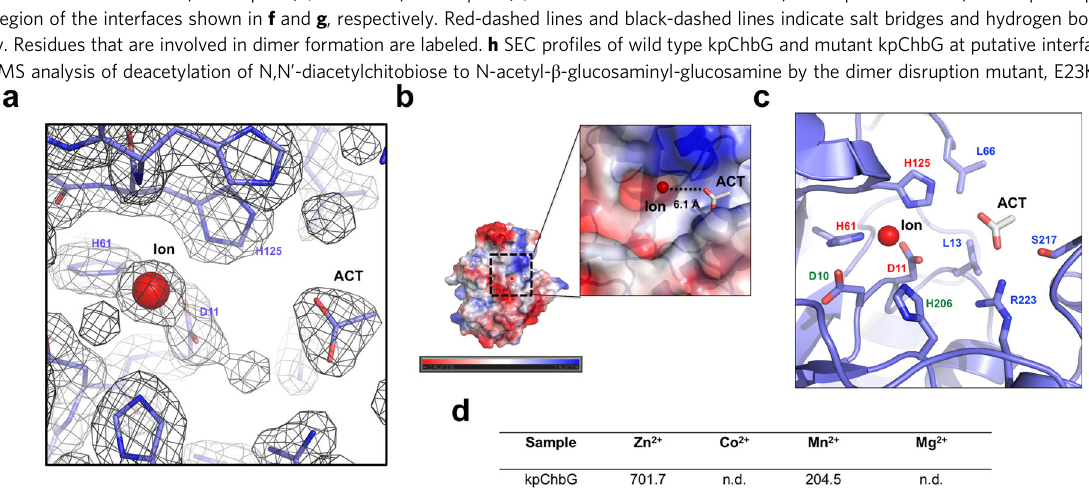
Fig. 3 Identi fi cation of the Zn2 + (Ion) and acetate (ACT) ion in the putative active site of kpChbG. a The electron density map around the metal ion binding site of kpChbG. The 2Fo-Fc map contoured at the 1 σ level is shown. Residues coordinated with the metal ion are labeled. b Electrostatic surface representation of kpChbG. The scale bar ranges from − 7.3 kT/e (red) to 7.3 kT/e (blue). The black dashed box shows the magni fi ed region of the putative active site. c Cartoon representation of the putative active site of kpChbG. Residues involved in coordination of the metal ion and acetate ion are colored red and blue, respectively. Critical residues involved in kpChbG catalysis (D10 and H206) are colored green. d Table showing the metal ion concentration in kpChbG ( µ g/kg) analyzed by ICP-MS. n.d.: not determined.